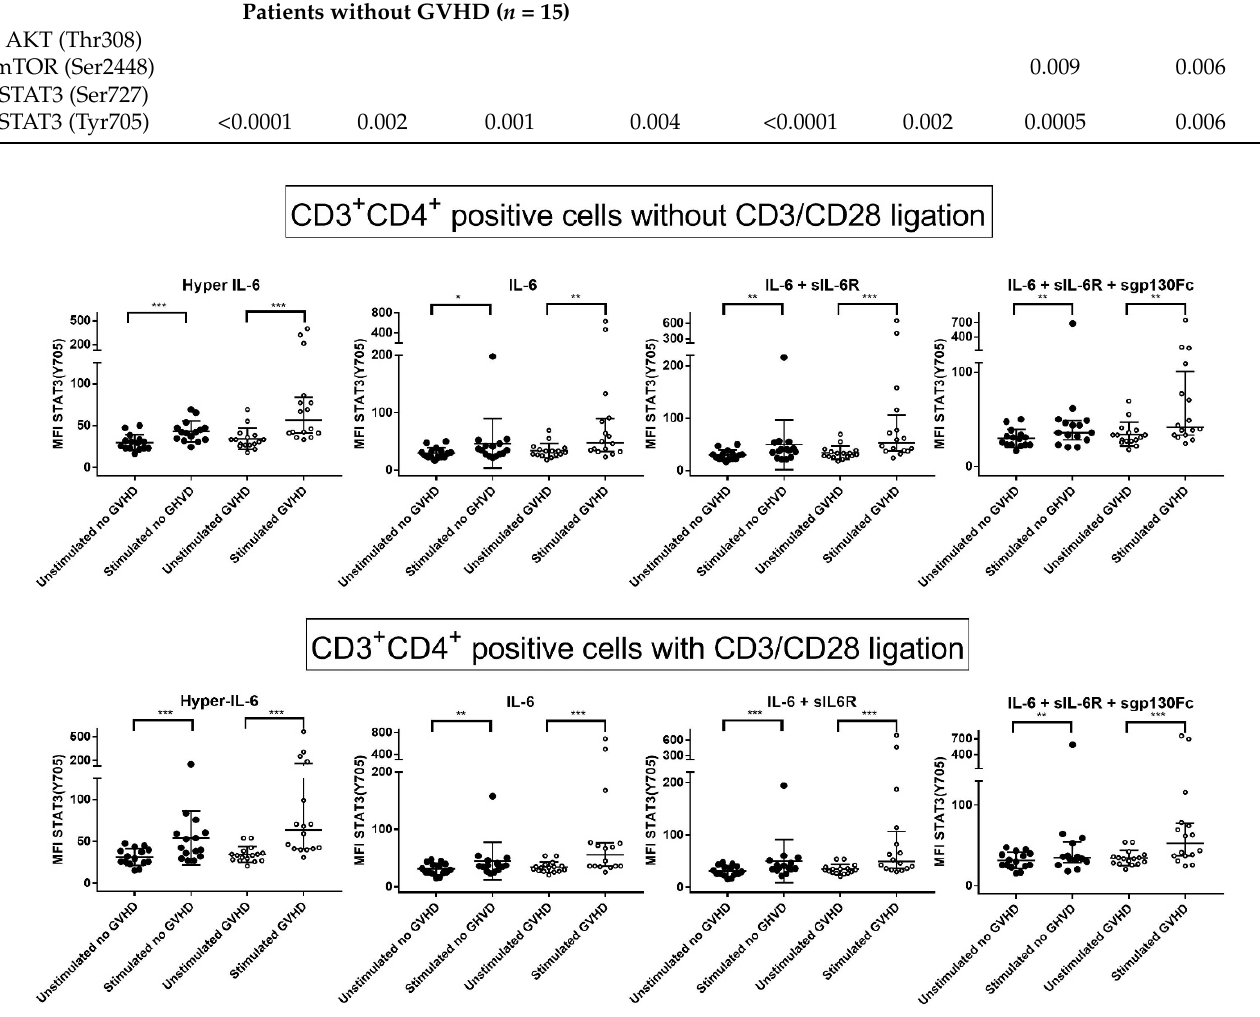
Figure 3. The effect of classical and trans IL-6 signaling on STAT3 (Tyr705) phosphorylation for post-transplant CD3 + CD4 + T cells derived from 31 allotransplant recipients on day +90 post-transplant; a comparison of patients with and without previous acute GVHD. The T cells were stimulated either with hyper IL-6 ( left , trans-signaling), IL-6 ( middle left , classical signaling), IL-6+IL-6R ( middle right , classical and trans-signaling) and IL-6+sIL-6R+sgp130FC, classical signaling). IL-6 stimulation was tested in the absence ( upper part ) and in the presence ( lower part ) of the T cell activation signal anti-CD3 + anti-CD28. The results are presented as the mean fluorescence intensity (MFI), and for each of the four IL-6 stimulations, we compared patients without (dark symbols) and with previous acute GVHD (open symbols). The Wilcoxon signed-rank test was used for the statistical analyses. * indicates a p -value 0.05 to 0.01, ** indicates a p -value 0.001 to 0.001, *** indicates p -value < 0.001.